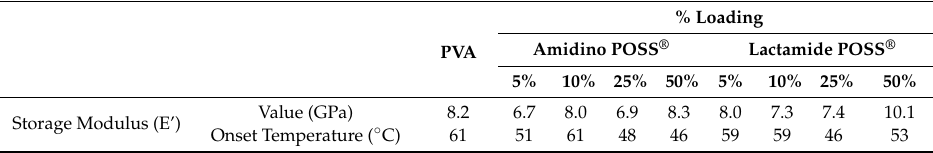
Table 3. Storage modulus (E’) for the different nanocomposite